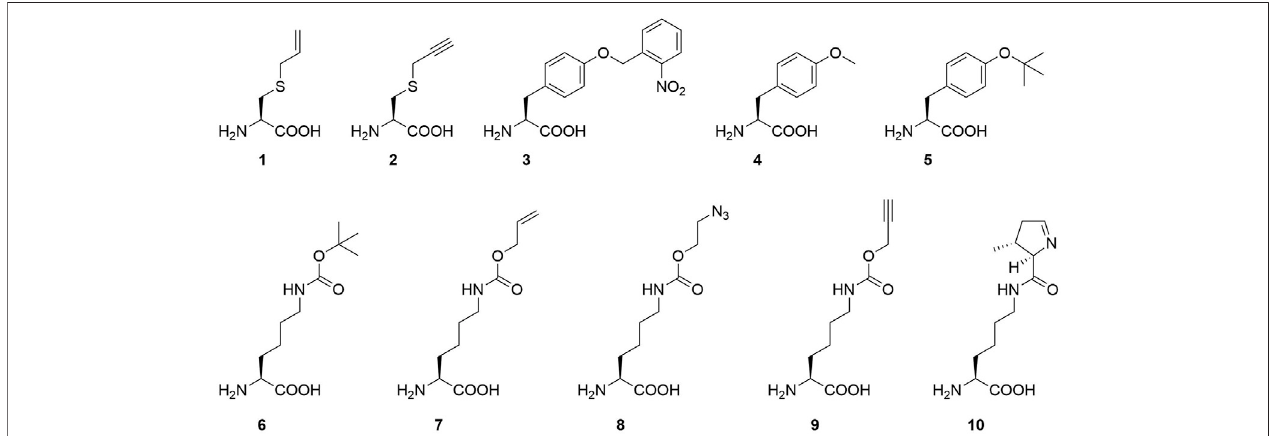
FIGURE2| OverviewofncAAsusedinthisstudy(1-9)andthenaturalPylRSsubstrate(10): S -allyl- L -cysteine(Sac,1), S -propargyl- L -cysteine(2), o -(2-nitrobenzyl)- L -tyrosine (ONBY, 3), ( O- methyl- L -tyrosine ( O- methyl- L -tyr, 4), O-tert -butyl- L -tyrosine ( O-tert -butyl- L -tyr, 5), N ε -t ert -butoxycarbonyl- L -lysine (BocK, 6), N ε - allyloxycarbonyl- L -lysine (AllocK, 7), N ε -((2-azidoethoxy)carbonyl)- L -lysine (AzidoK, 8) and N ε -propargyloxycarbonyl- L -lysine (ProK, 9), Pyrrolysine (Pyl,